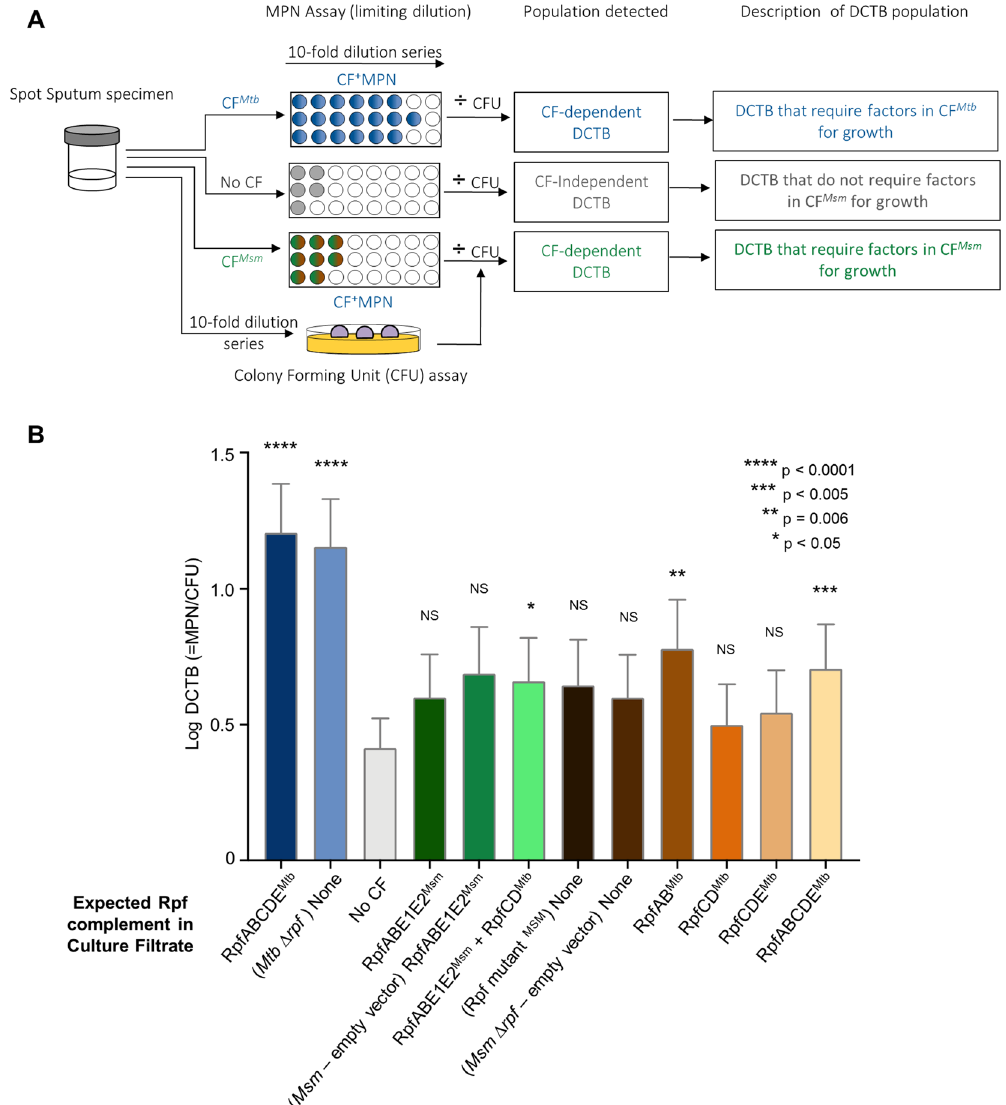
Figure 4. Bacterial yield in DCTB assays using CF from Msm strains expressing Mtb Rpfs in various combinations. (A ) Assessment of DCTB recovery from sputum cultures using CF supplementation. DCTB were detected using the MPN limiting dilution assay. For comparison, CF containing and deficient in Mtb and Msm Rpf was used to assess the role of Rpfs in growth stimulation. To control for the effect of CF in growth stimulation, fresh Middlebrook media was used. CF from various recombinant Msm strains was used to assess if expression of Mtb Rpfs in Msm yields CF that can be used to stimulate DCTB in sputum specimens in a manner that is comparable to Mtb CF. To obtain the DCTB count, MPN values (with or without CF) were divided by CFU counts, which depict conventionally culturable bacteria. ( B ) Histogram depicting mean DCTB counts from assays using CF from Mtb and Msm. The mean DCTB counts were compared to that obtained from no CF assays using a Wilcoxon test to determine the growth stimulatory effect of the various CFs. Error bars depict the standard error of the mean. P-values depict the comparison of any given CF to the no CF or empty vector control. Graph was generated using Graphpad Prism software, Version